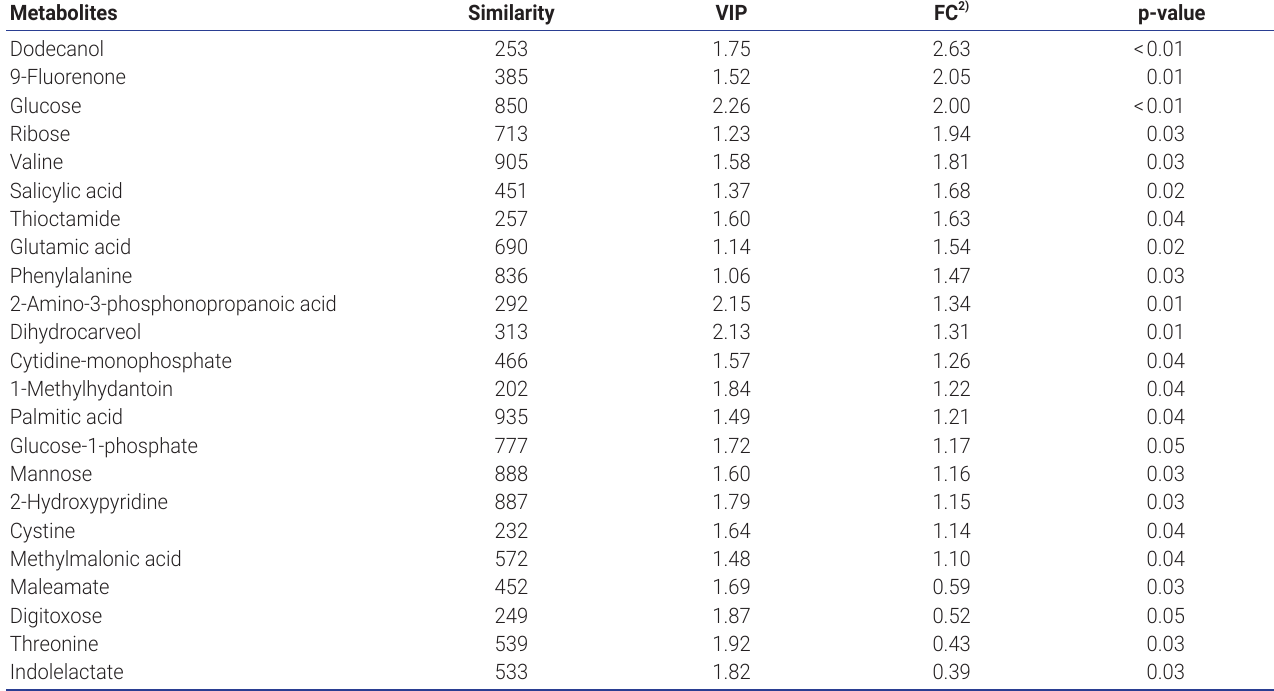
Table 3. Identification of significantly different metabolites in plasma between the CON 1) and DAN 1) groups